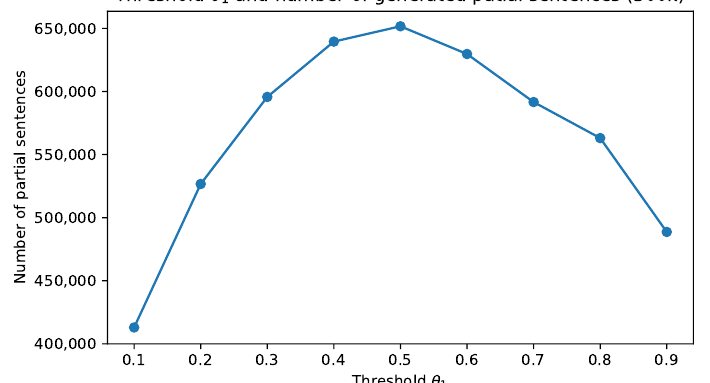
Figure 4. Threshold θ 1 and number of generated partial sentences (300k).